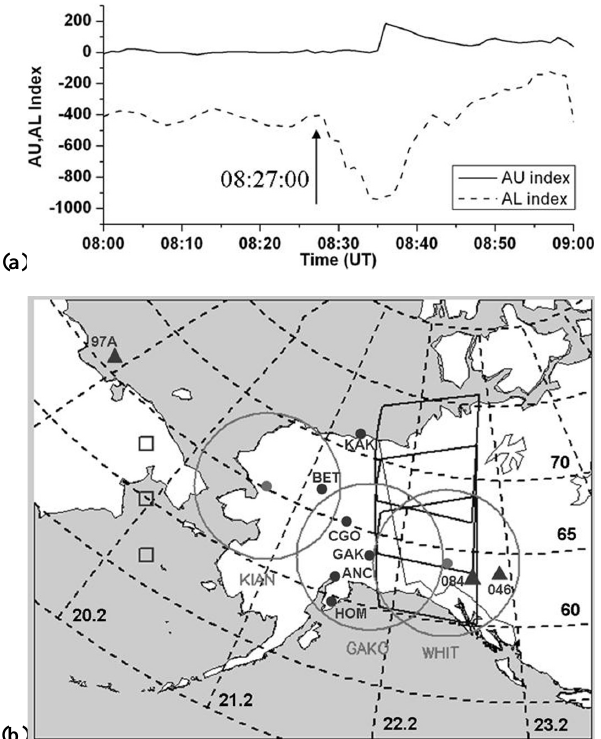
Fig. 1. (a) AU and AL indices during the 21 December 2006 sub- storm; (b) Locations of the ground-based All-Sky Imagers (ASIs, shown as grey solid circles) at KIAN, GAKO and WHIT, mag- netometer sites (shown as dark solid circles) at Kaktovik (KAK), Bettles (BET) and College International Geophysical Observatory (CGO), Gakona (GAK), Anchorage (ANC), and Homer (HOM), and field line footpoints of geosynchronous satellites (LANL-97A, 1994-084, 1989-046 shown as solid triangles) and FORMOSAT-2 satellite (shown as squares). Large circles are the FOVs of the ASIs. The FOVs of ISUAL aboard the FORMOSAT-2 are shown as trape-